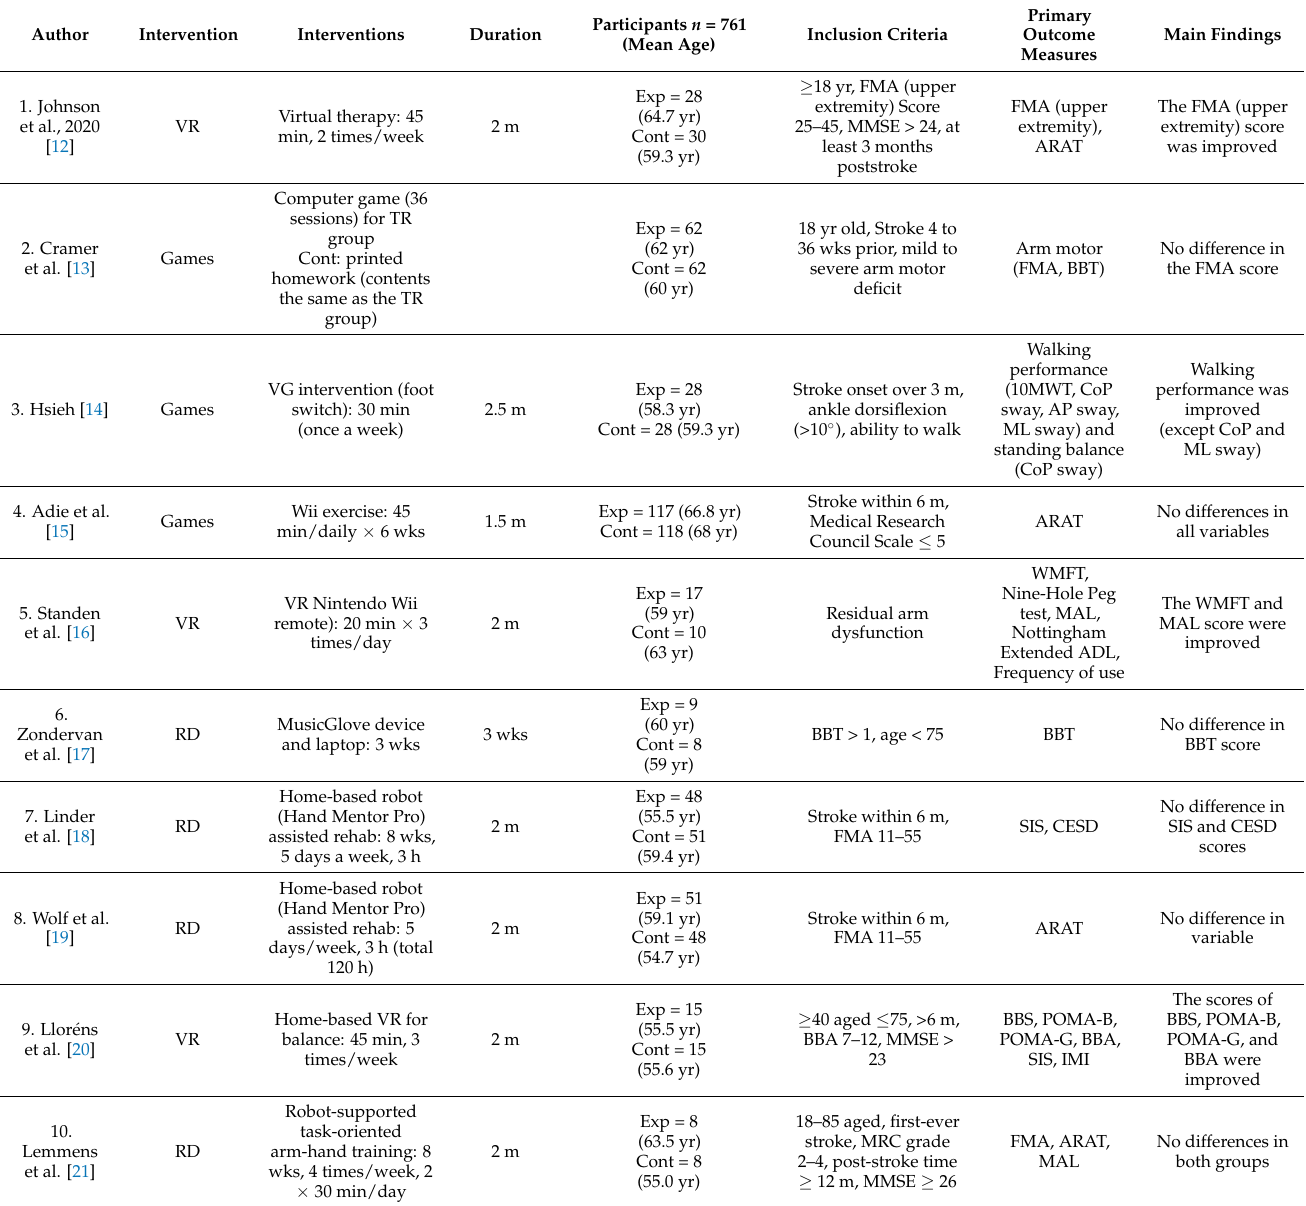
Table 1. Characteristics of the Ten